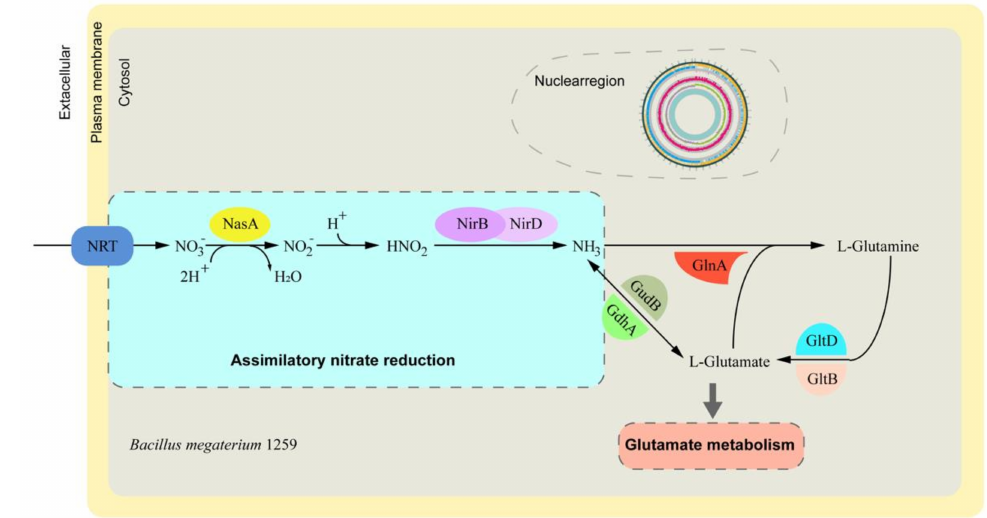
Figure 3. Model of the nitrate assimilation pathway in BM1259.